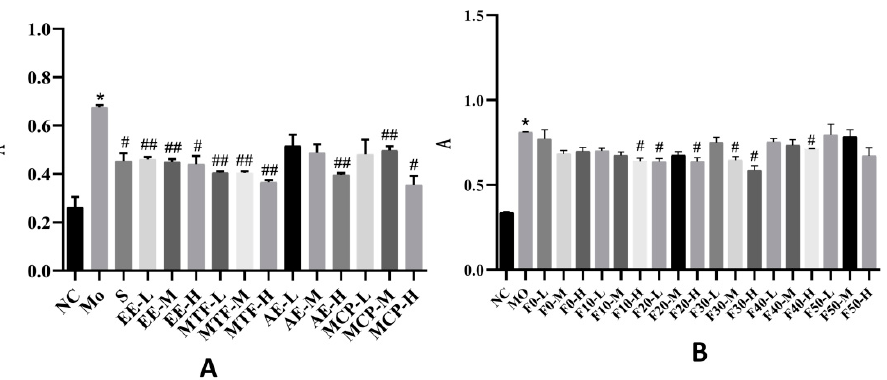
Figure 5. Effects of MCB extracts on total lipid accumulation in HepG2 cells. ( A ) the absorbance of MCB extracts on total lipid accumulation. ( B ) the absorbance of the fractions on total lipid accumulation. NC: control group, Mo: model group, S: drug group, 50: low dose group, M: moderate dose group, H: high dose group, EE: ethanol extract, AE: aqueous extract, MTF: total flavonoids, MCP: crude polysaccharides, macroporous resin fractional eluent: F0, F10, F20, F30, F40 and F50. “*” indicates p < 0.05 compared with the NC group. “#” and “##” respectively indicate p < 0.05 and p < 0.01 compared with the Mo group.